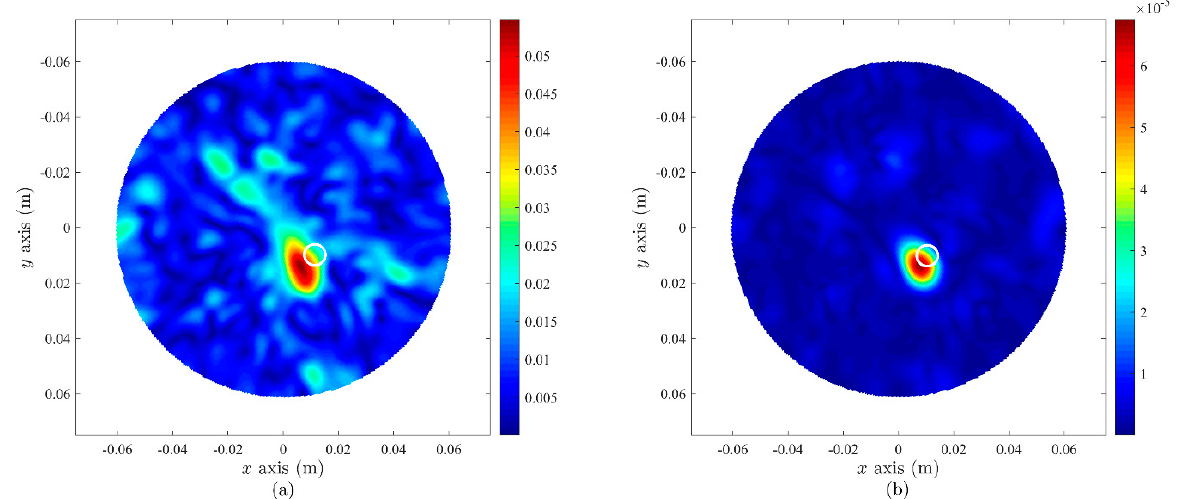
Figure 22. Microwave imaging results based on experimental setup using the proposed antenna and fabricated breast phantom considering a cancer inside. Result based on ( a ) DAS and ( b ) DMAS imaging algorithms.